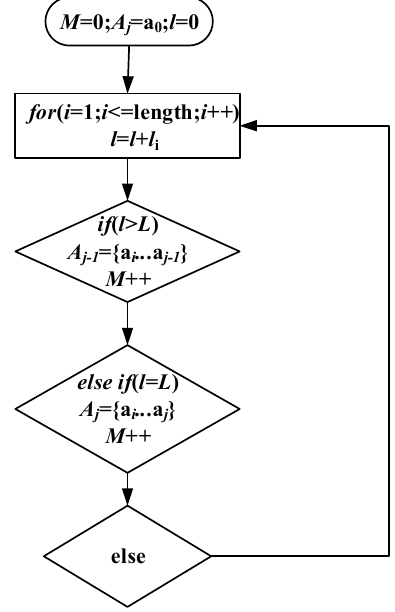
Figure 8. Flow chart of chromosome decoding.